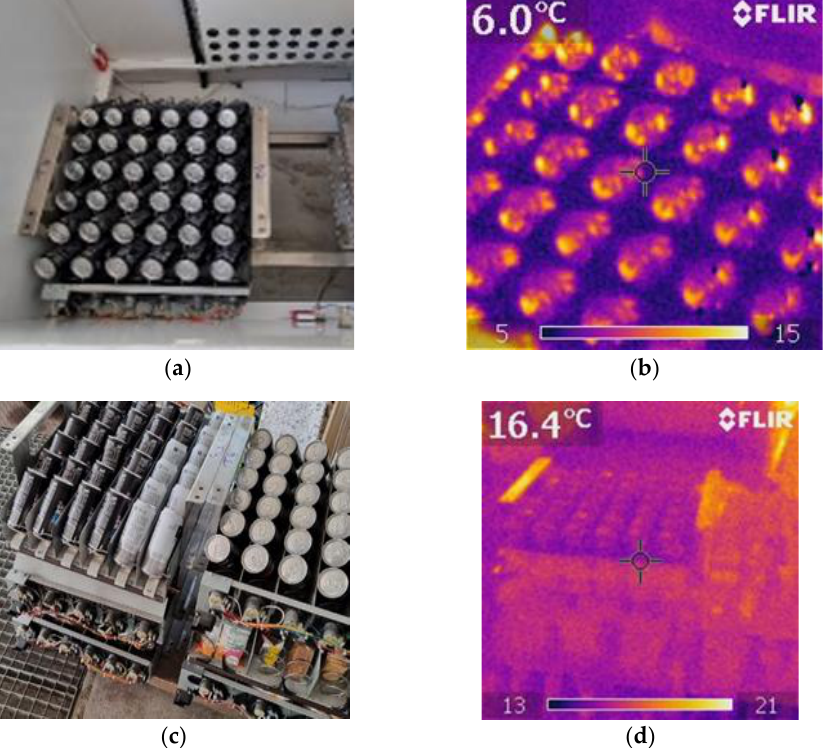
Figure 8. Thermal images. ( a , b ) Products from inside the vending machine before replacement. ( c , d ) Newly introduced products .